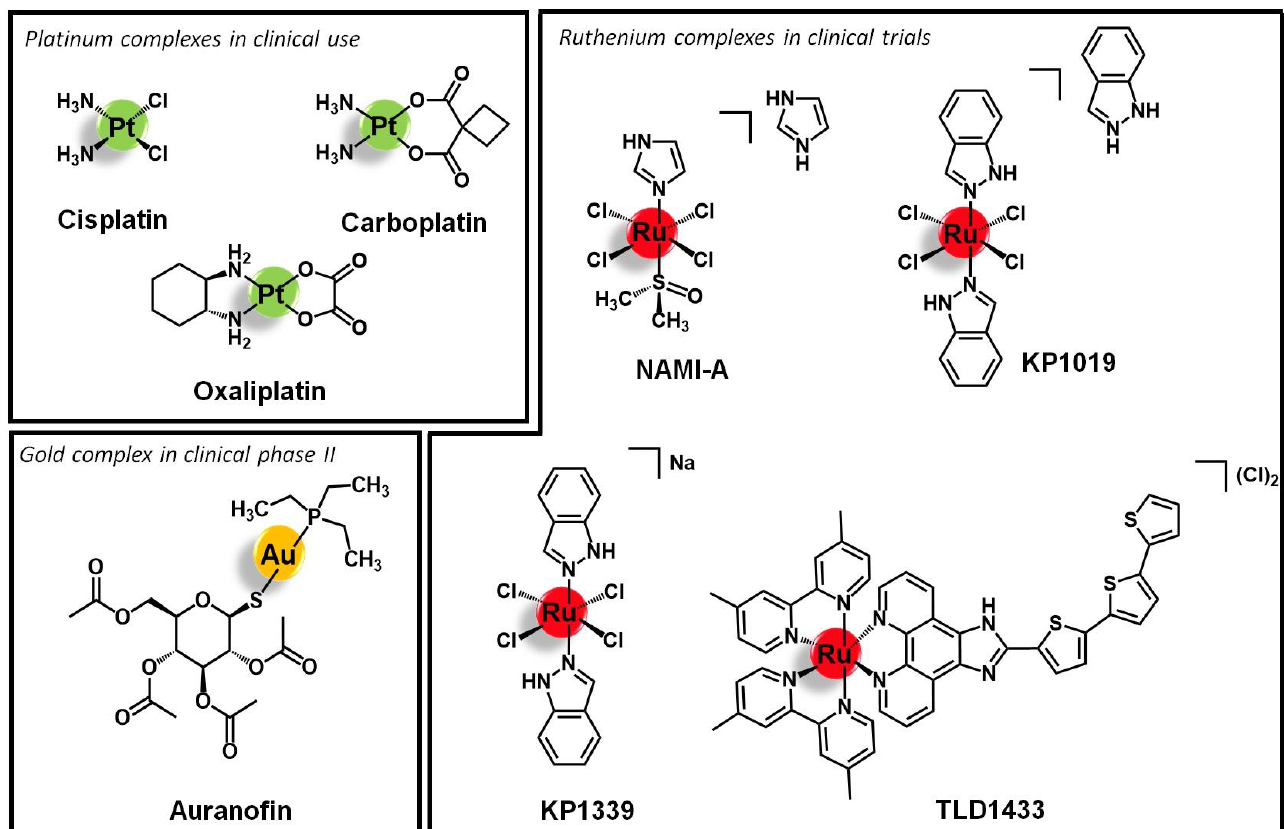
Figure 1. Selected platinum, ruthenium, and gold anticancer lead structures.